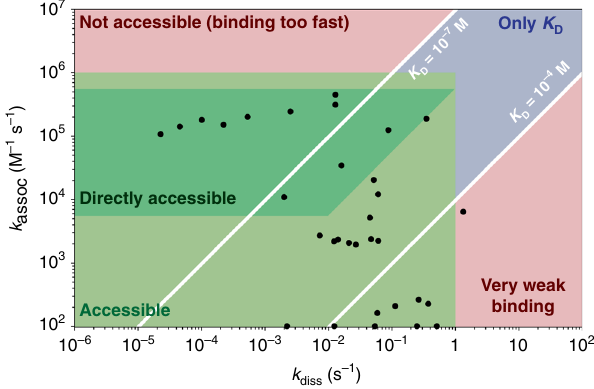
Fig. 6 k assoc and k diss for bimolecular interactions compatible with the temperature-jump source. The compatible area, represented in green, was plotted based on three strict criteria: (1) the time needed to fold/unfold half the complexes is longer than 0.16 s ( t 1/2 > 160 ms); (2) the plateau is reached in the time scale of the experiment (32 s); and (3) the concentration of the folded species changes by at least 20% of the total concentration. In dark green, the kinetics can be recorded directly at 10 µ M in both target and ligand. Light green: the concentrations of the ligand and/ or the target have to be adjusted to be able to access kinetics (concentrations decreased to 1 µ M in both ligand and target if the reaction is too fast and concentration of the ligand increased to 100 µ M or more if the reaction is too slow). Blue: the kinetics are too fast for the source and only the equilibrium constant is accessible with good con fi dence using mass spectrometry. Red: combinations that are not compatible with the current setup. Note that on the scheme the zones are de fi ned with hard borders; however, in practice, the compatible zone is not so strictly de fi ned. The black dots correspond to the values determined for the multimolecular biological systems reported in this manuscript. Since the fi ttings for the the unfolding reactions, the dots were placed on the x